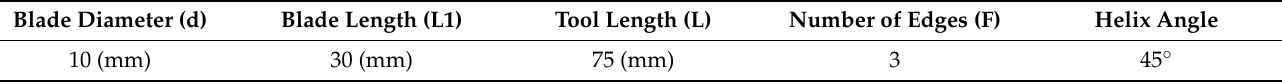
Table 1. Tool S220 specifications.